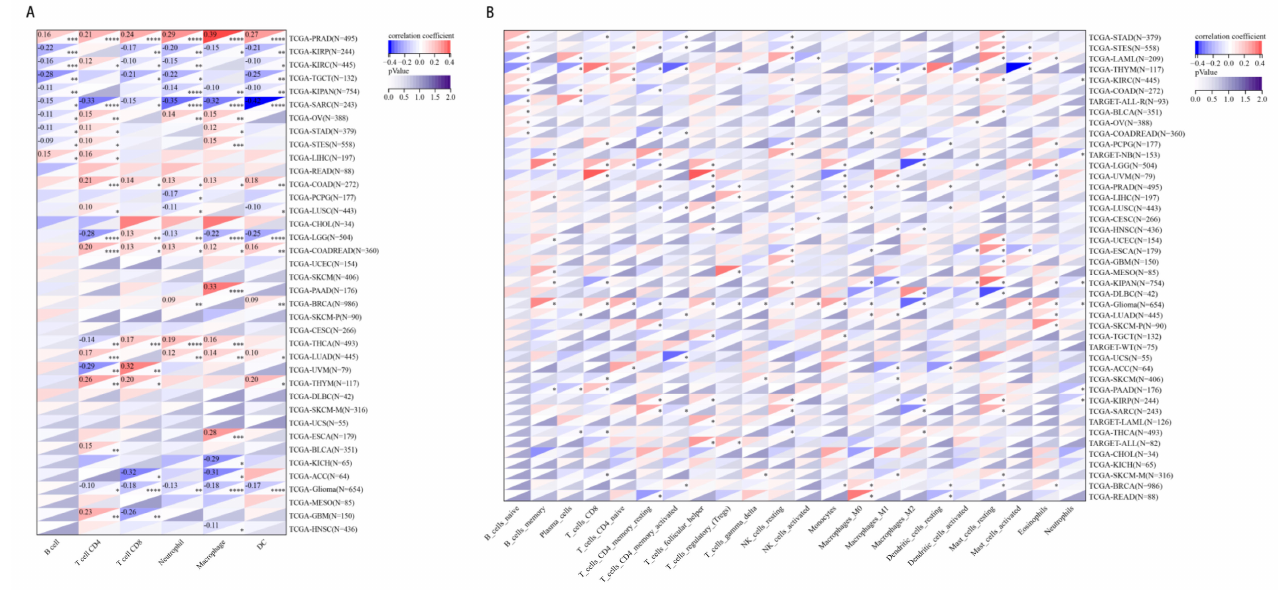
Figure 6. Pan-cancer analysis of the relationship between CHD5 expression and immune cell infil- tration. ( A ) Correlation between CHD5 expression and B cell, CD4+T cell, CD8+ T cell, neutrophil, macrophage, DC infiltration in each patient. ( B ) CHD5 expression was significantly associated with immune cell infiltration in 41 types of cancers. * p < 0.05; ** p < 0.01, *** p < 0.001, **** p <